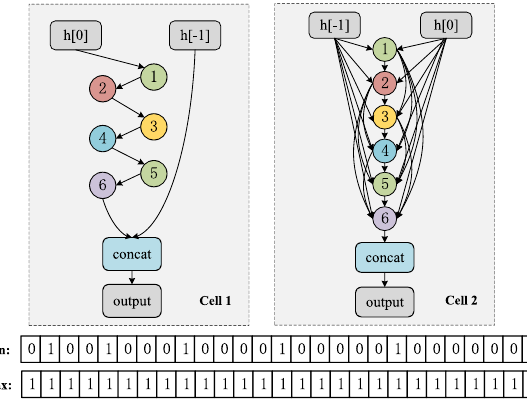
Fig.4 Example of two cell structures with extreme density values. The former indicates the most sparse structure, while the latter represents the most densely connected structure